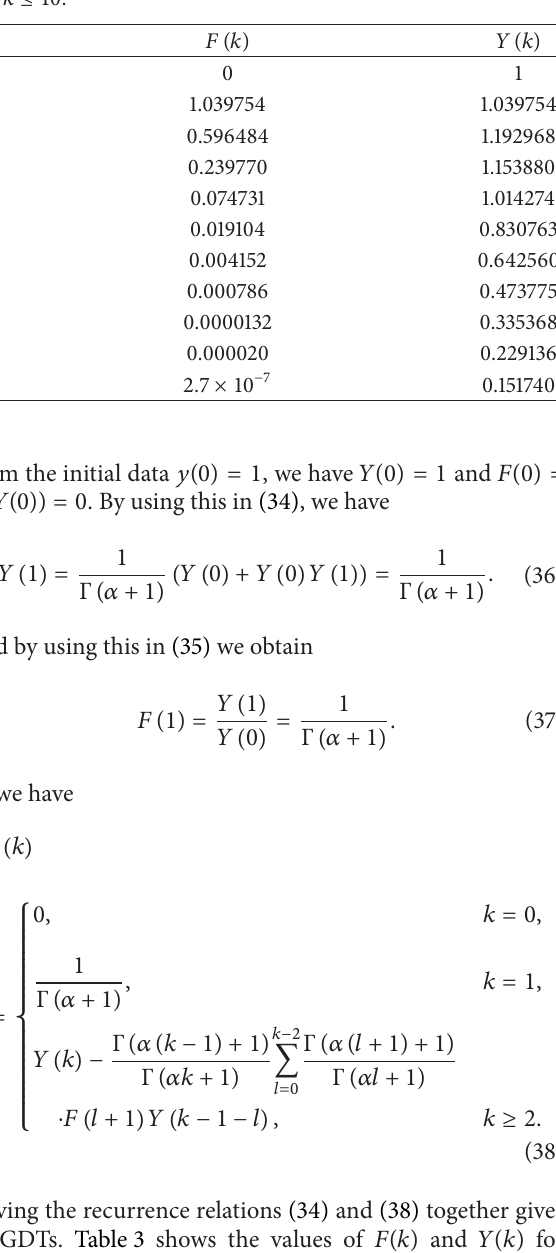
Table 4: 𝑆 𝑛 (𝑡) and |𝑅 𝛼 𝑛 (𝑡)| values in Example 2 for 𝛼 = 0.9 , 𝑡 = 0.05 .